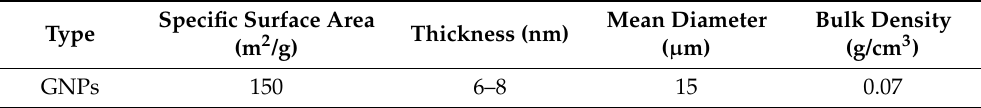
Table 2. Properties of GNPs